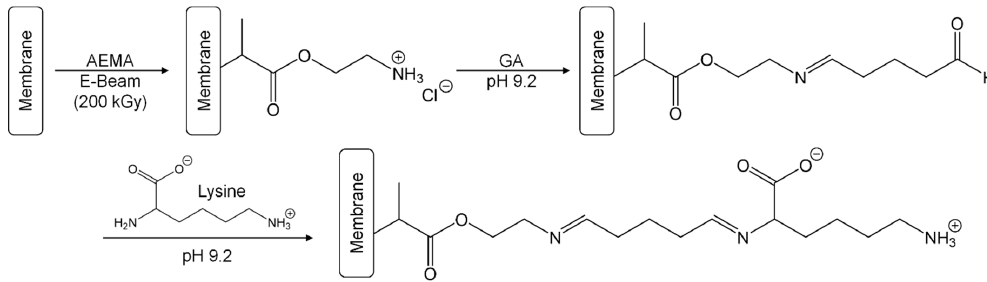
Figure 1. The synthesis of the PES–Lysine membrane is a three-step process starting with the